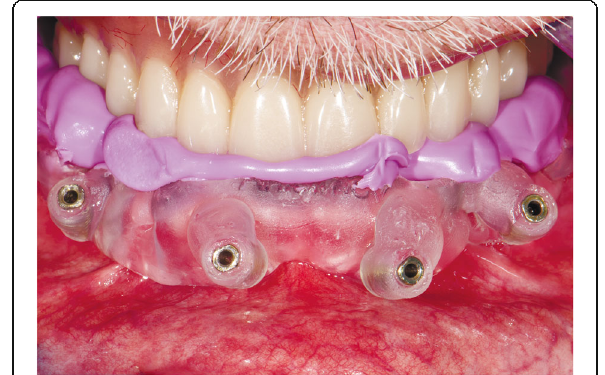
Fig. 11 Guided implant placement